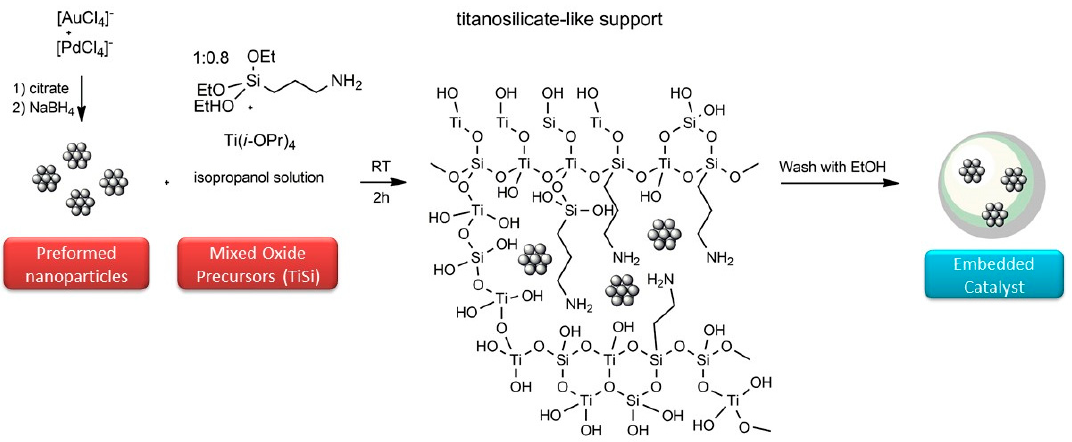
Scheme 1. Schematic representation of the synthesis